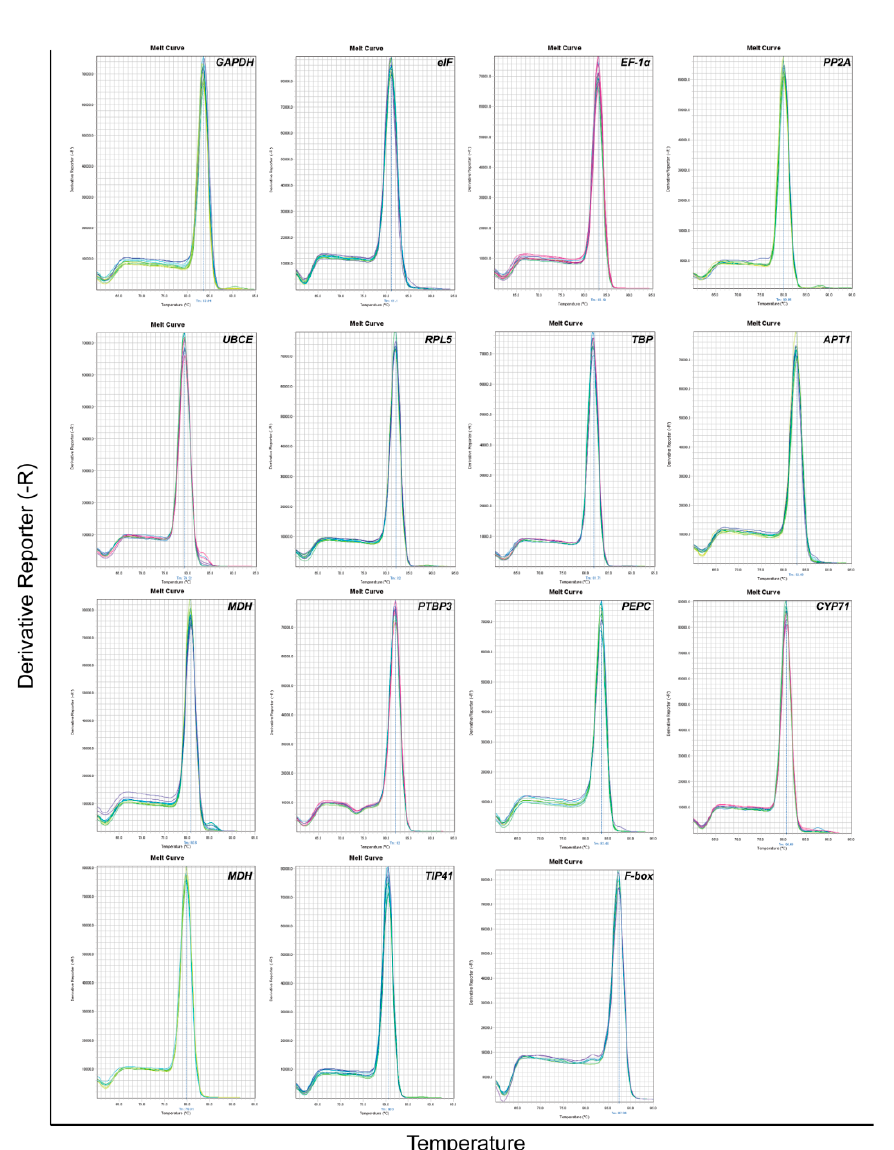
Figure 1. Specificity of primer pairs of all candidate reference genes for qPCR amplification. Here, M represents the DNA size marker. Lanes 1–15 are as follows: TBP , UBCE , NCBP2 , eIF , APT1 , RPL5 ,